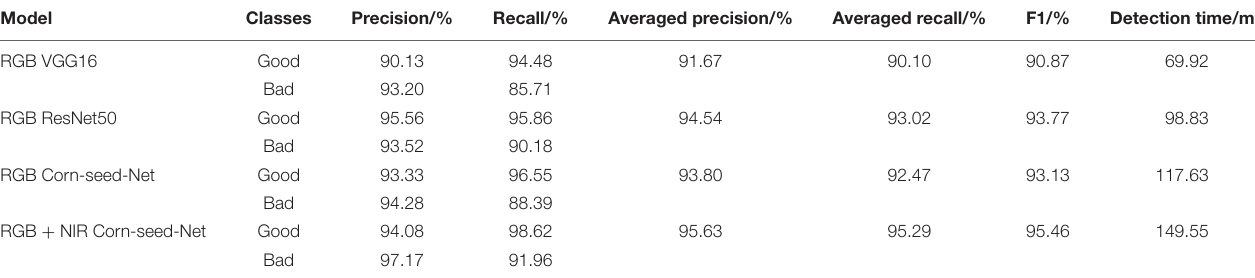
TABLE 4 | Comparison of model performance combined with watershed algorithm using RGB images. Model